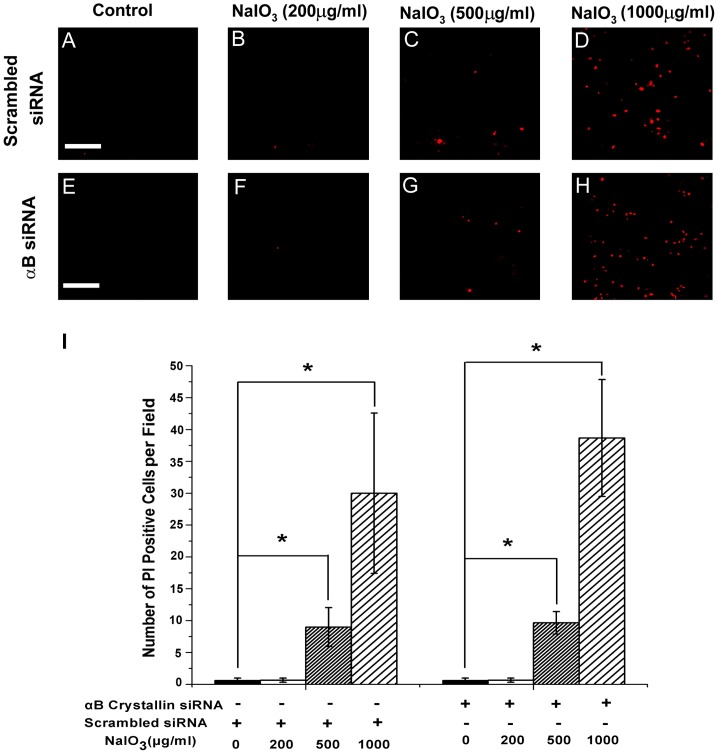
Occurrence of necrosis with high doses of NaIO3 in human RPE cells.Forty-eight hours after scrambled siRNA or αB crystallin siRNA transfection, RPE cells were treated with 200, 500, 1000 µg/ml NaIO3 for 24hours. Propidium iodide (PI) staining positive cells were determined in scrambled siRNA-transfected RPE cells (A–D) and αB crystallin siRNA-transfected human RPE cells (E–H) treated with NaIO3. Treatment with 500 and 1000 µg/ml of NaIO3 resulted in increased PI positive cells both in control RPE cells and αB crystallin siRNA pretreated human RPE cells (I). However, no significant differences were found between the number of PI positive cells in control RPE groups and αB crystallin siRNA-transfected group (I). Data are mean ± SEM from three individual experiments, αB siRNA refers to αB crystallin siRNA. *P<0.05. Scale bar = 40 µm.